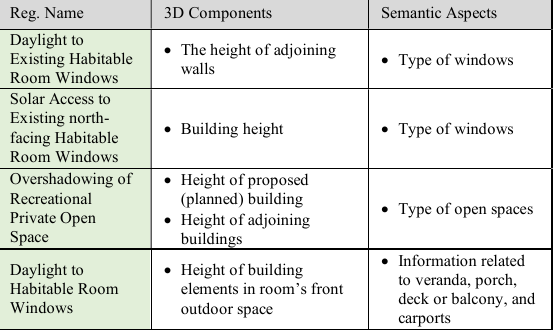
Table 2. Lights and shadows regulations